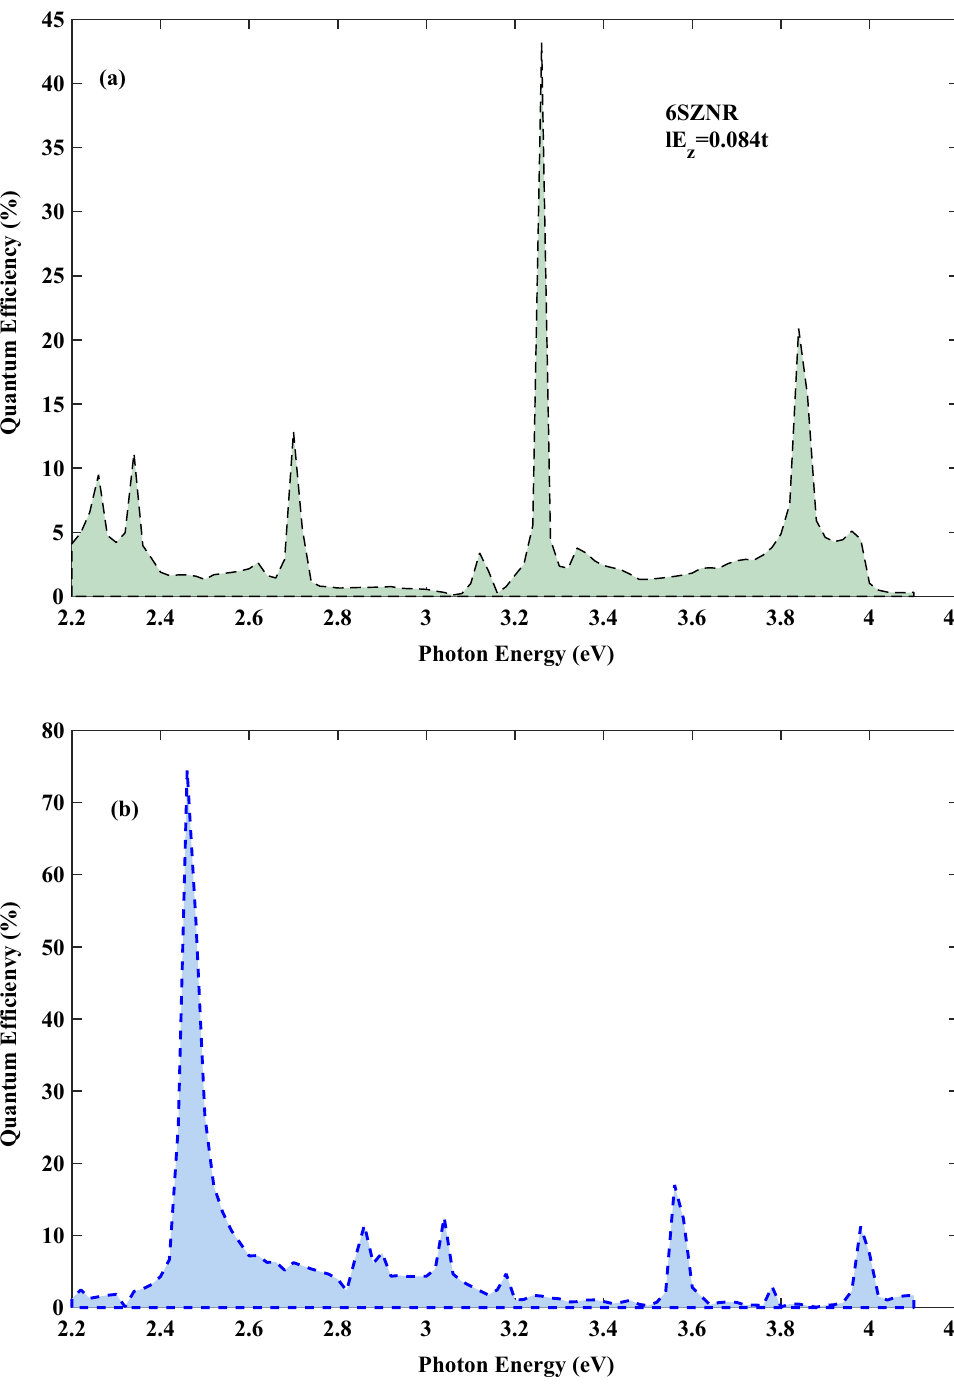
0.084 t and ( b ) for the spin- elE z =